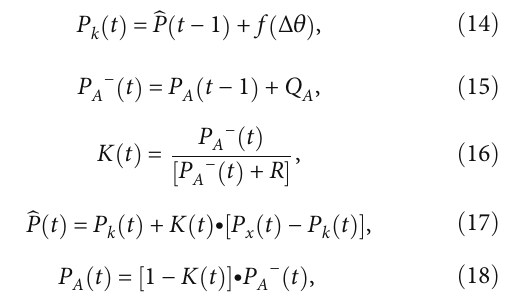
Figure 8: Pressure estimation of GG based on Kalman ’ s